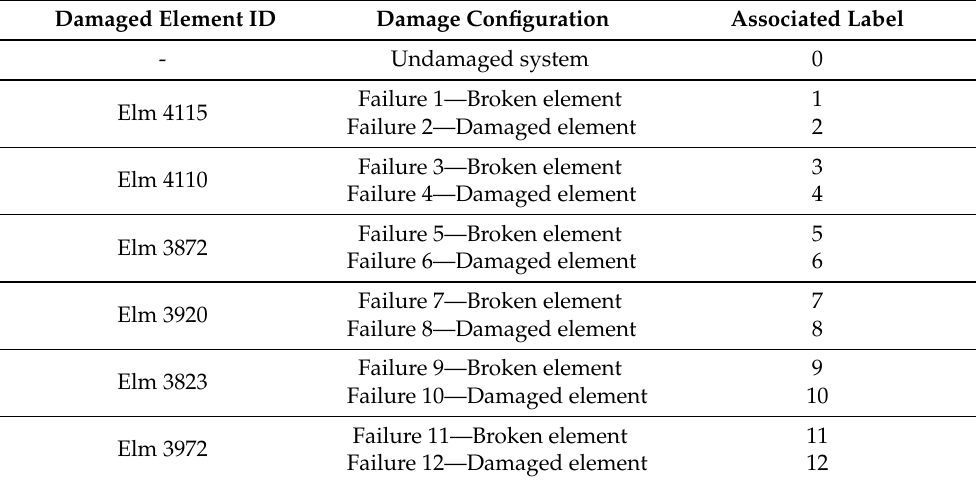
Figure 2. Mode shapes and natural frequency of the assembled spacecraft. Table 3. Damaged element ID, associated damage configuration (broken or partial failure), and associated